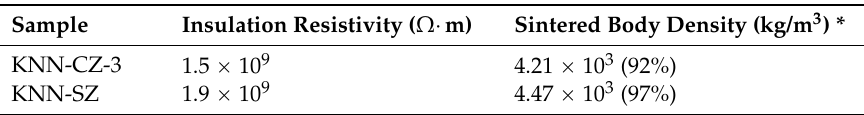
Table 8. Insulation resistivity and sintered body density of multilayer Sn 2+ -doped KNN-based ceramic samples (measured temperature: 25 ˝ C).